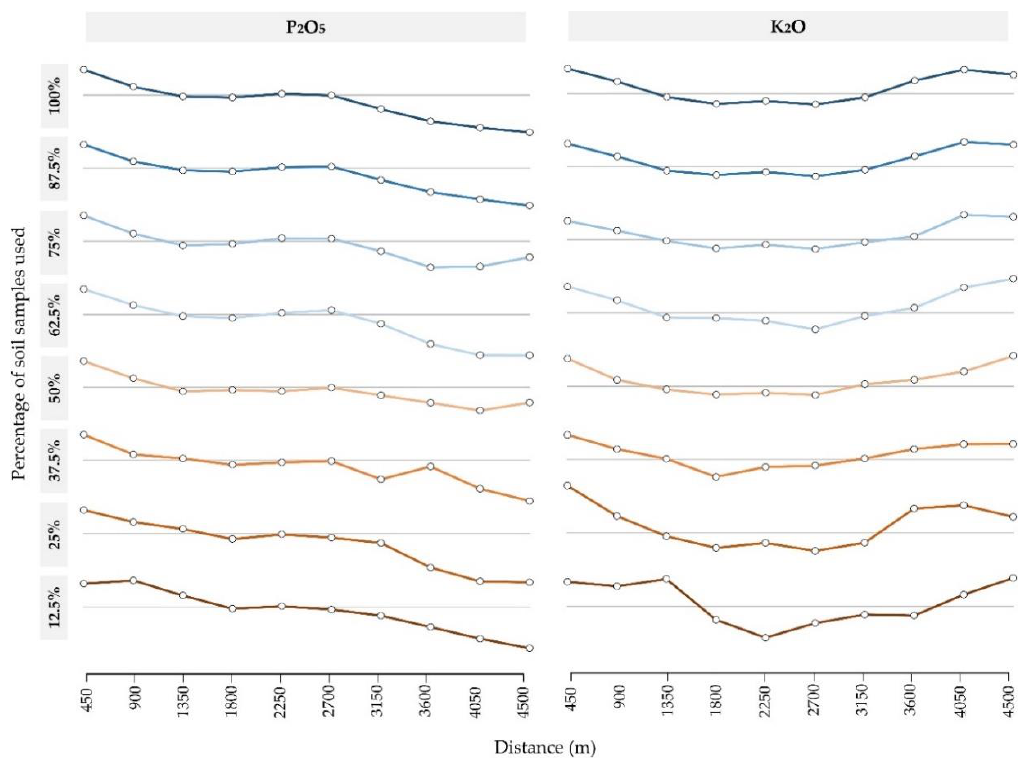
Figure A1. Correlograms of soil subsets, with the grey line indicating an autocorrelation value of zero.